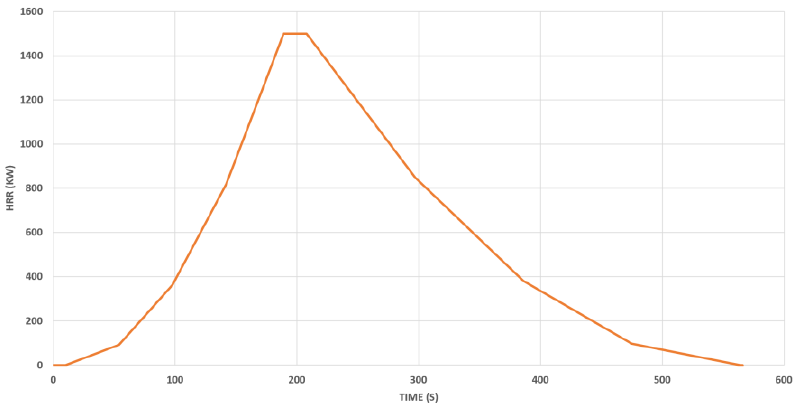
Figure 6. t-square growth, peak, and decay for fuel-controlled model fire.